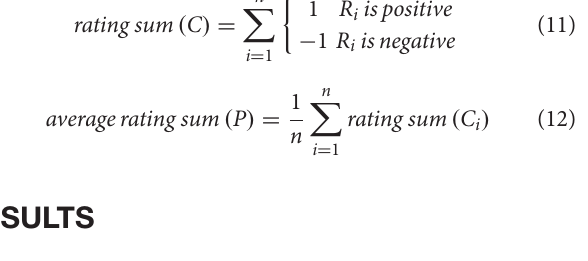
Frontiers in Marine Science |